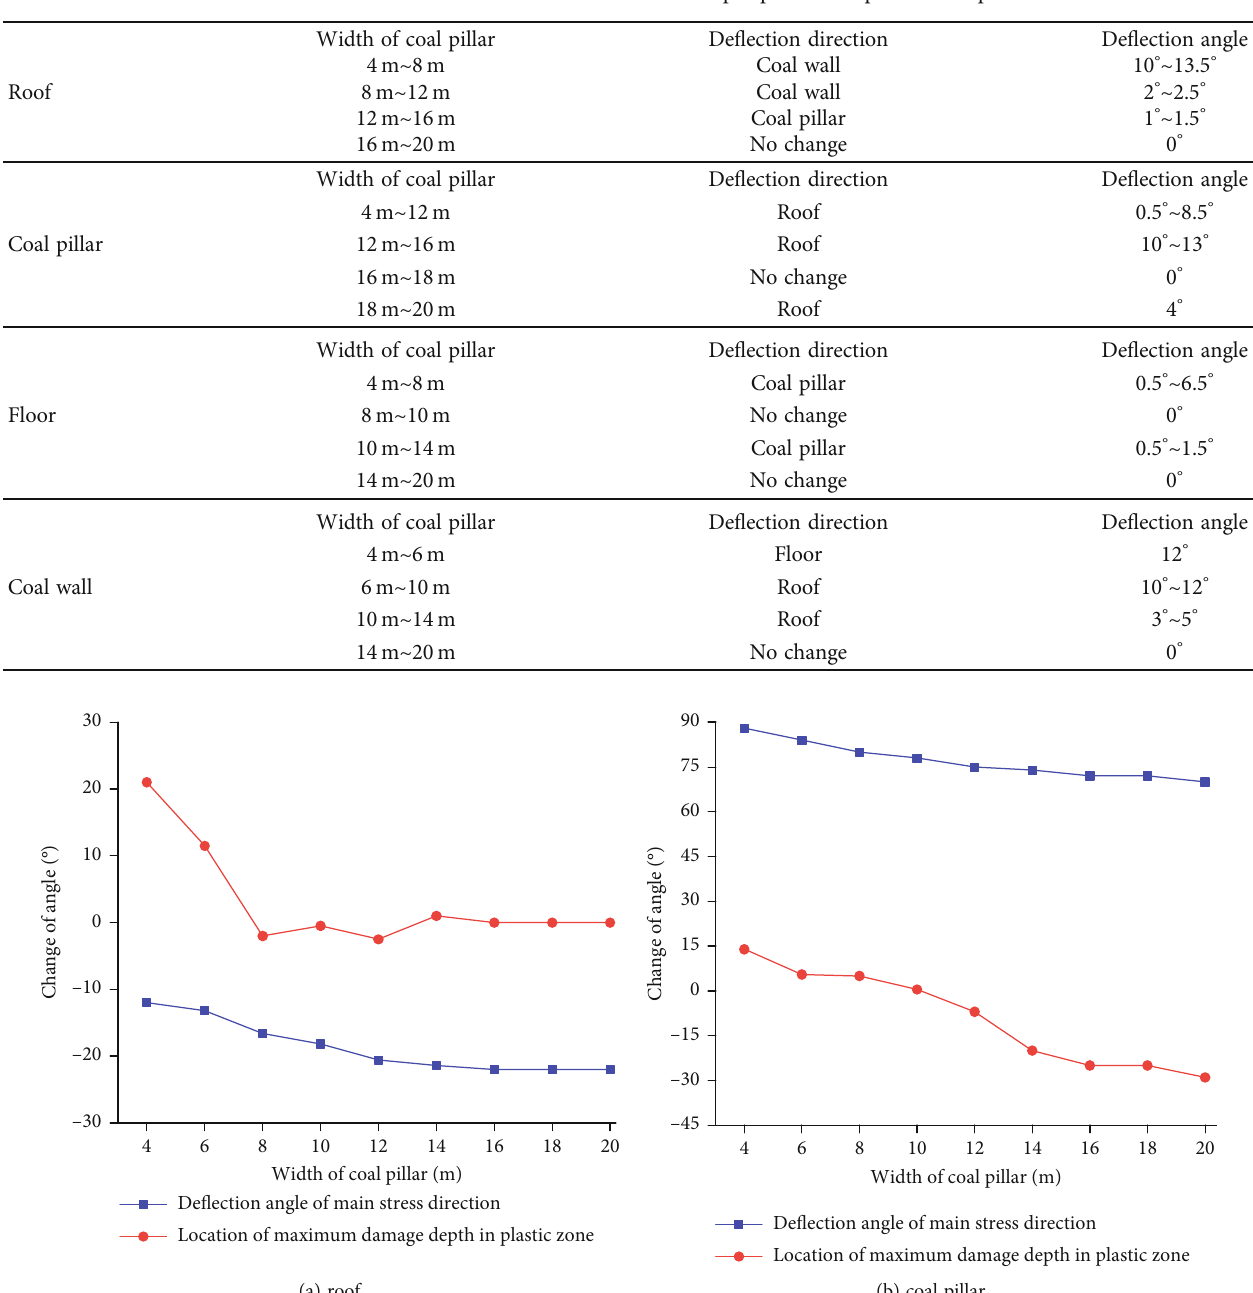
Table 4: The variation law of the maximum failure depth position in plastic zone pillar.